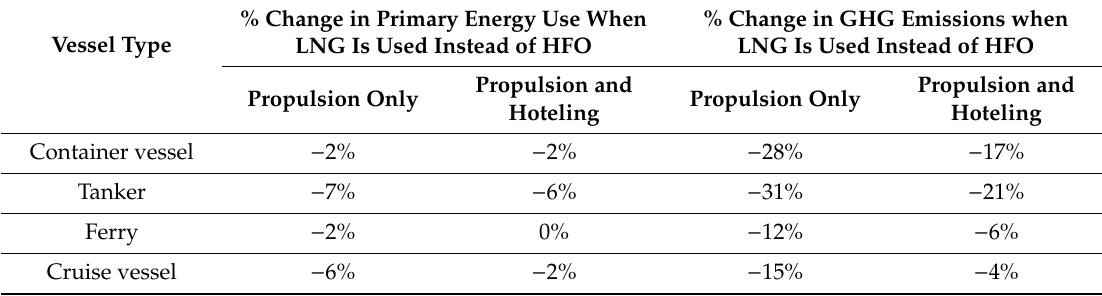
Table 5. Trends of different fuel scenarios for tank-to-propeller GHG emissions and PEU. Vessel